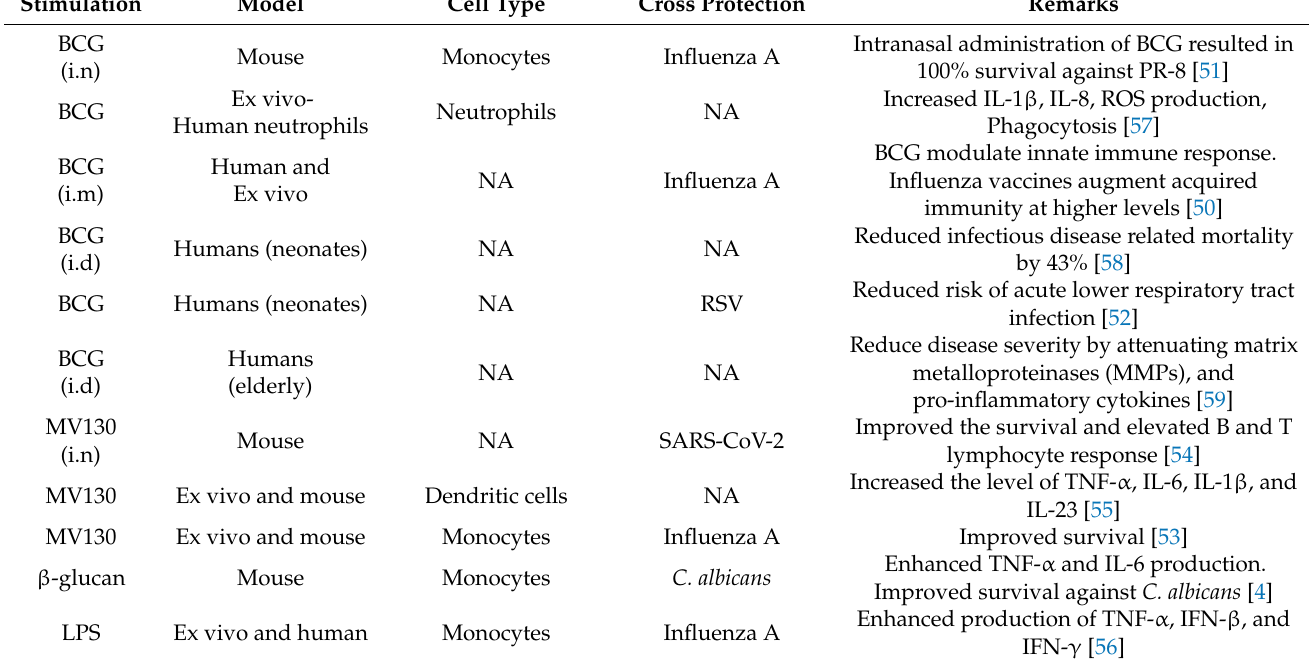
Table 1. Cross-reactivity of trained immunity induced by various stimulants against respiratory